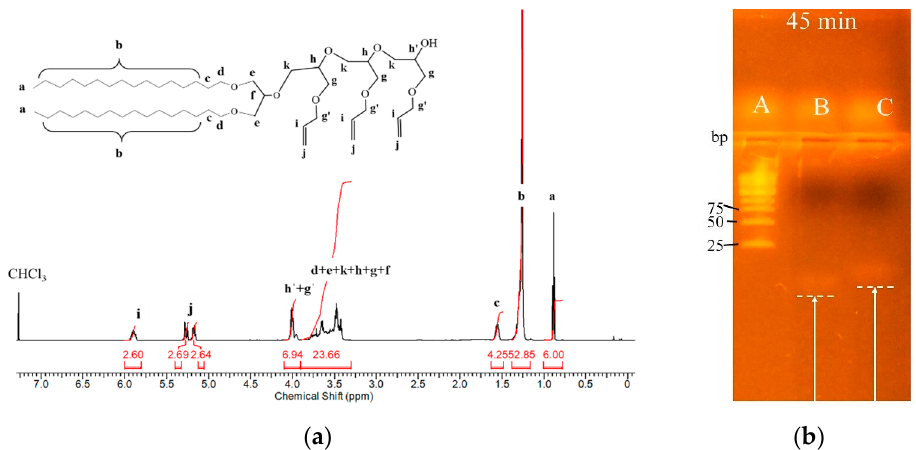
Figure 2. ( a ) 1 H NMR spectrum of the intermediate DHP-(AGE) n (n = 3) in CDCl 3 . ( b ) Agarose gel retardation patterns of thiolated oligonucleotide and the nucleolipid DHP - (AGE) 3 - oligonucleotide. The white arrows indicate the different retardations of the thiolated oligonucleotide (lane B) and nucleolipid (lane C). Nucleic acids were stained with ethidium bromide. Overall duration of the experiment 45 min as indicated. Lane A: molecular weight marker.